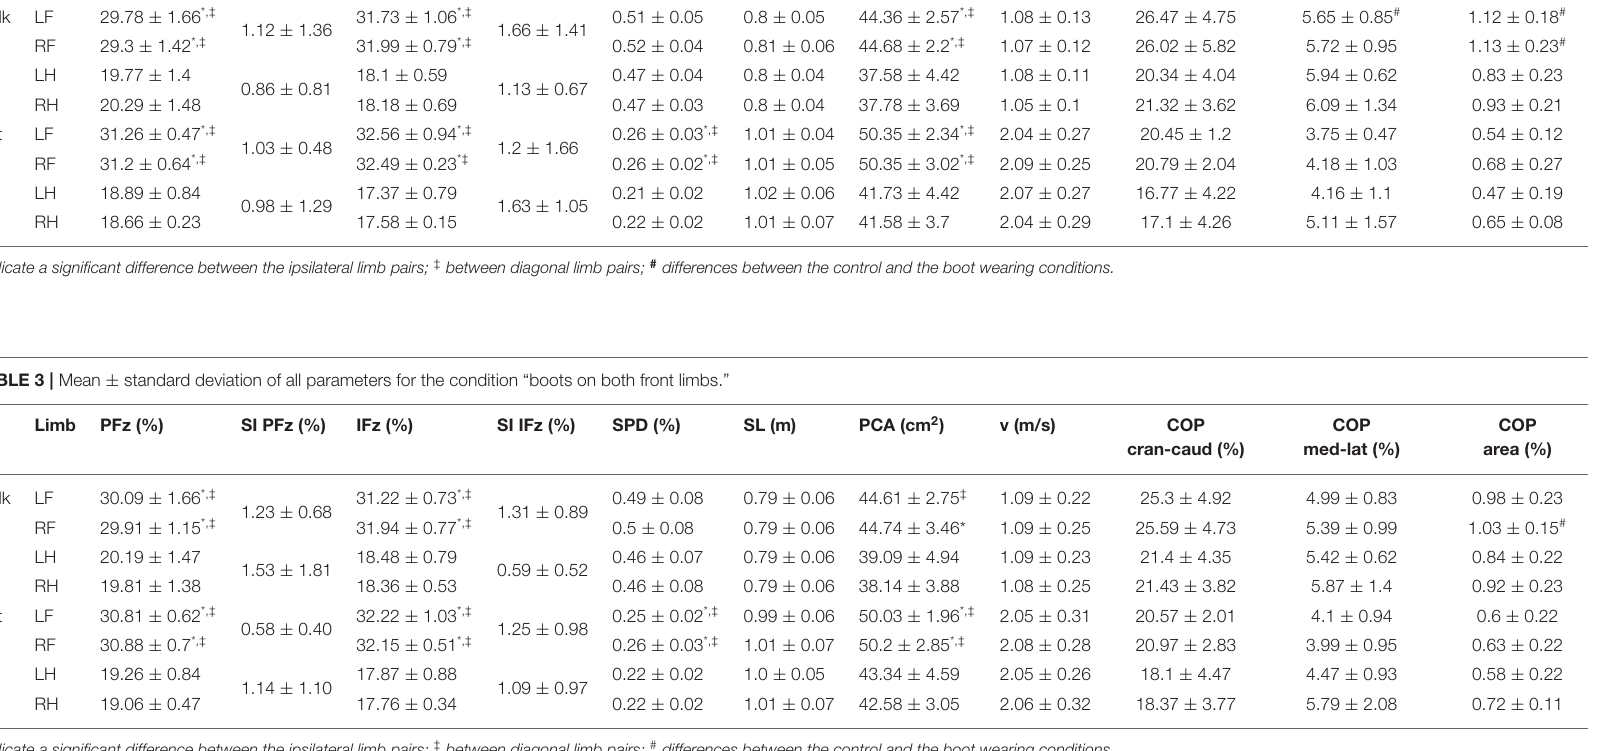
* Indicate a significant difference between the ipsilateral limb pairs; ‡ between diagonal limb pairs; # differences between the control and the boot wearing